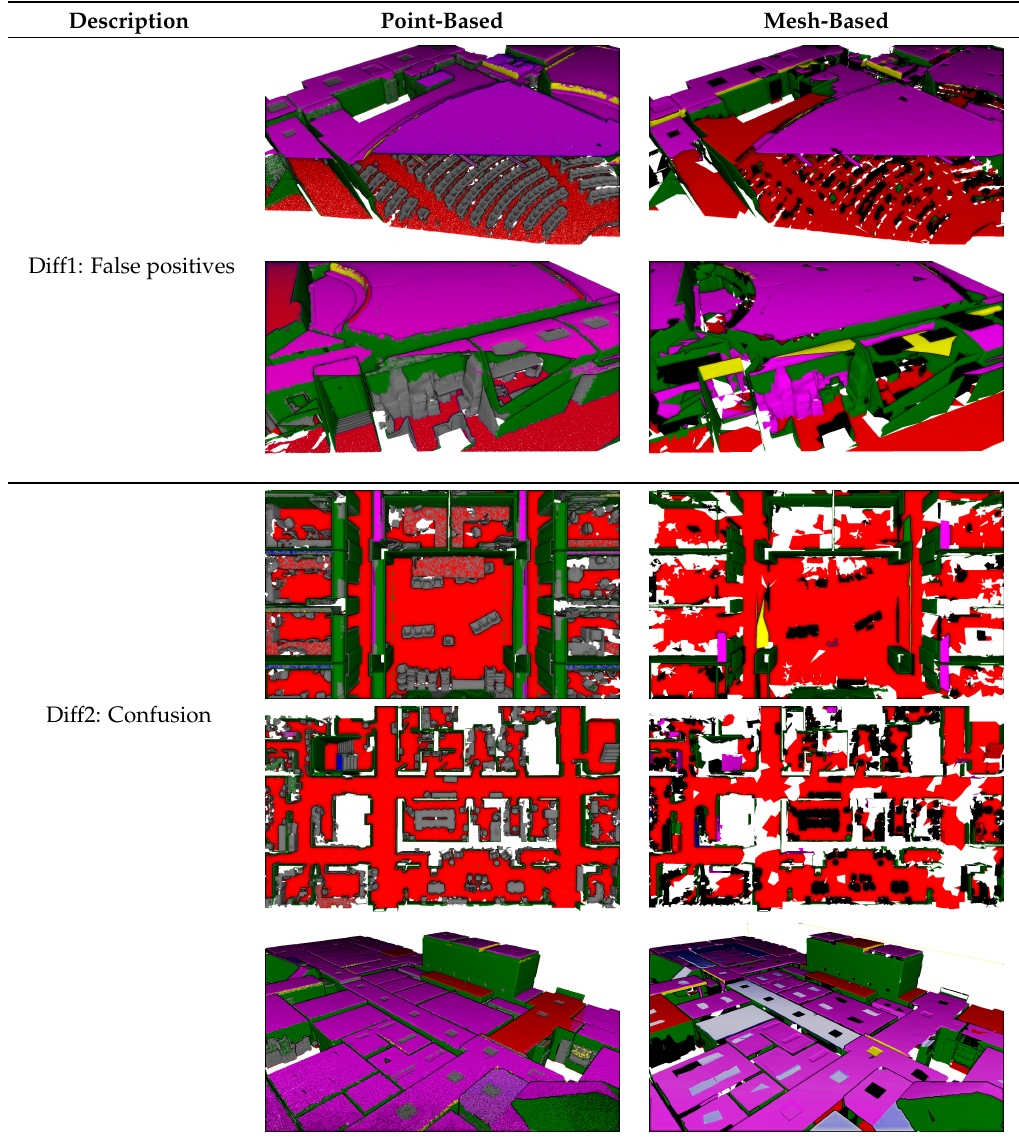
Figure 7. Visual inspection of the classification differences between the point-based and the mesh-based segments approach: ( top ) False positives between clutter and structural classes and ( bottom ) confusion between structural classes.